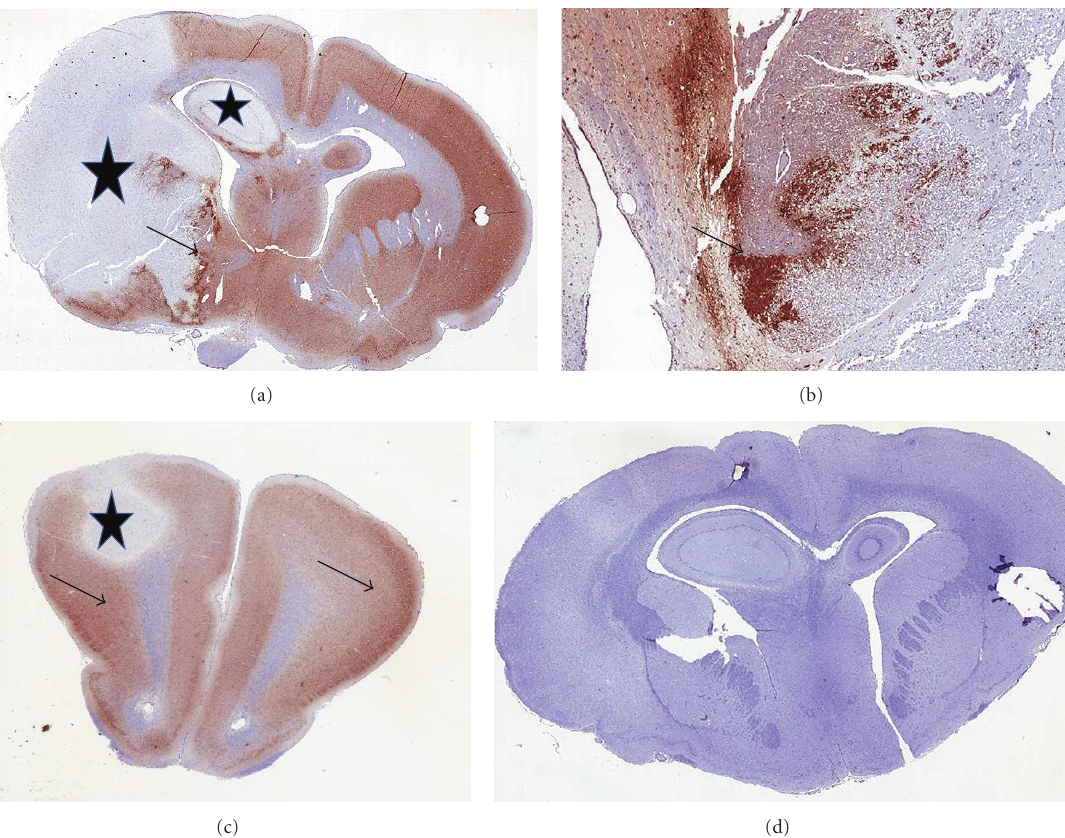
Figure 2: Pimonidazole stain identifies penumbra. (a) Intense staining is present in penumbra (arrow) adjacent to infarct (stars), 0 . 5 × magnification. (b) Closeup of area within the box demonstrates intense staining adjacent to infarct, 4 × magnification. (c) Di ff use weak staining (arrows) indicates mild hypoxia associated with euthanasia. Infarct does not stain (star.), 0 . 5 × magnification. Negative control